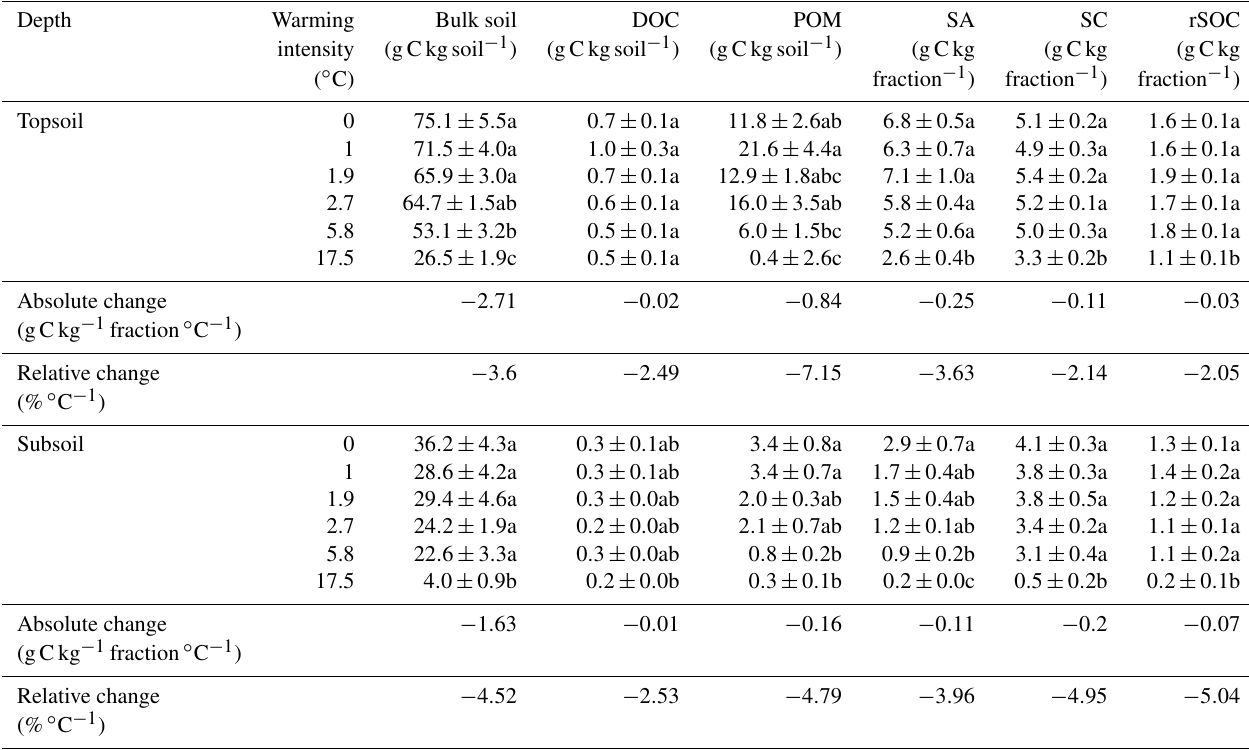
Table 1. The average soil organic carbon (SOC) content ( n = 5) of all fractions and the bulk soil including their standard errors. The letters following the numbers in the table indicate significant differences ( p < 0 . 05) across warming intensities ( ◦ C) within one soil depth. Absolute and relative changes in the SOC content as derived from linear regression models are also displayed for both of the investigated soil depths. Although this was not the best model in all cases, we used this value as a proxy to compare the warming response among fractions. Fractions were dissolved organic carbon (DOC), particulate organic matter (POM), SOC in sand and aggregates (SA), total silt- and clay-sized SOC (SC), and oxidation-resistant silt- and clay-sized SOC